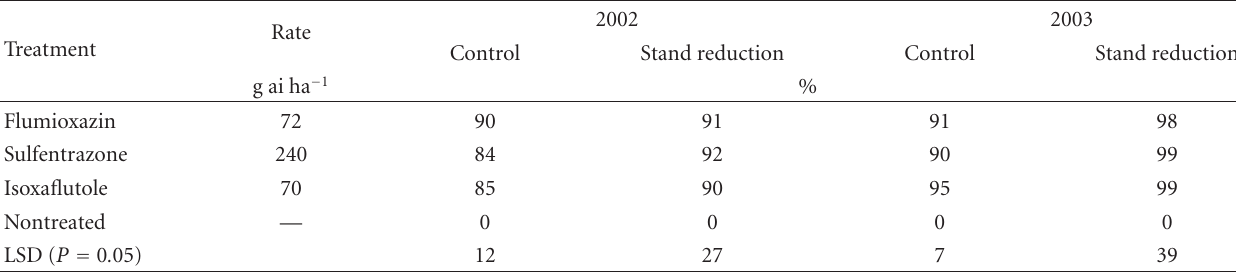
Table 2: Visual control and common waterhemp stand establishment 28 days after application of PRE herbicides in 2002 and 2003.